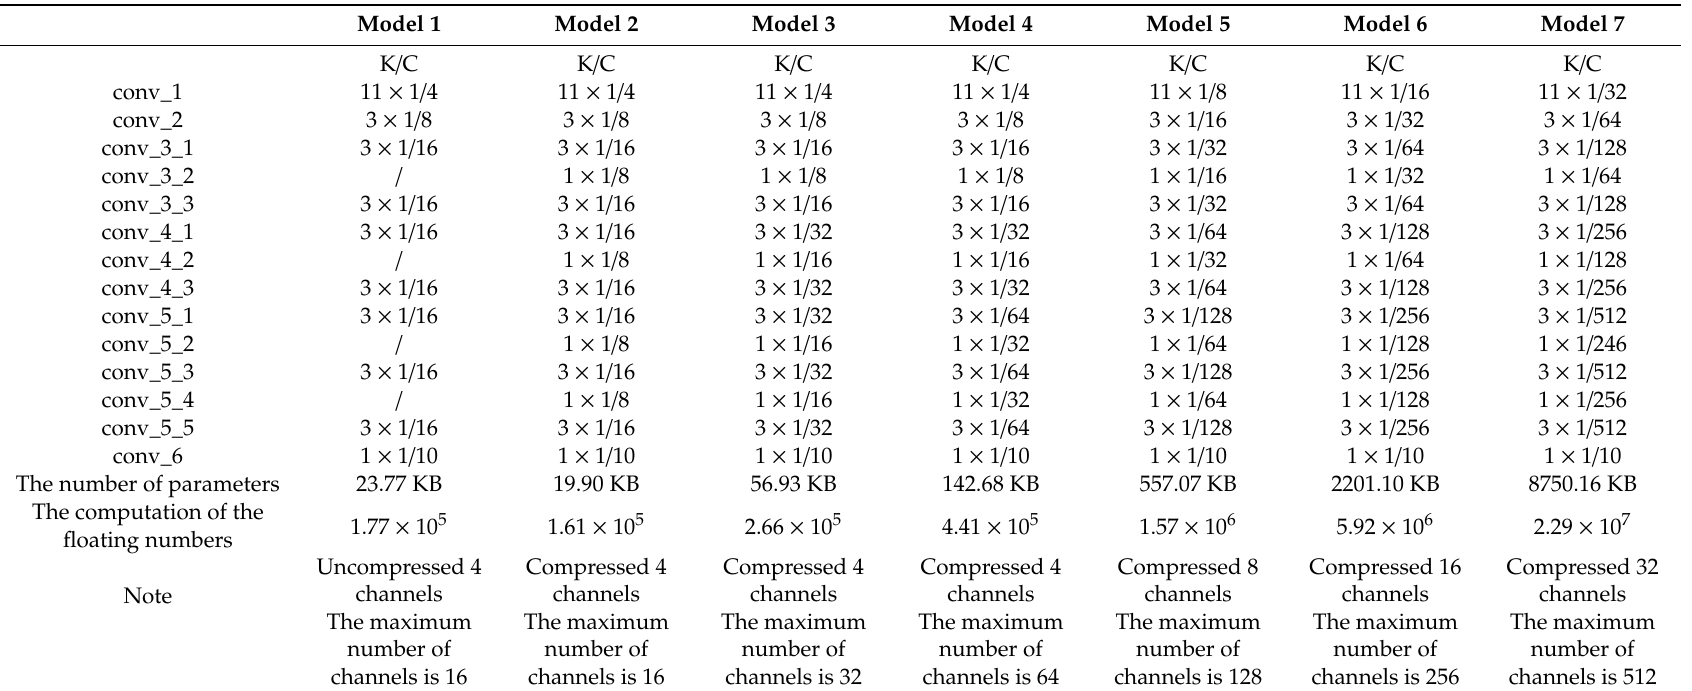
Table 2. Number of channels and structures for various